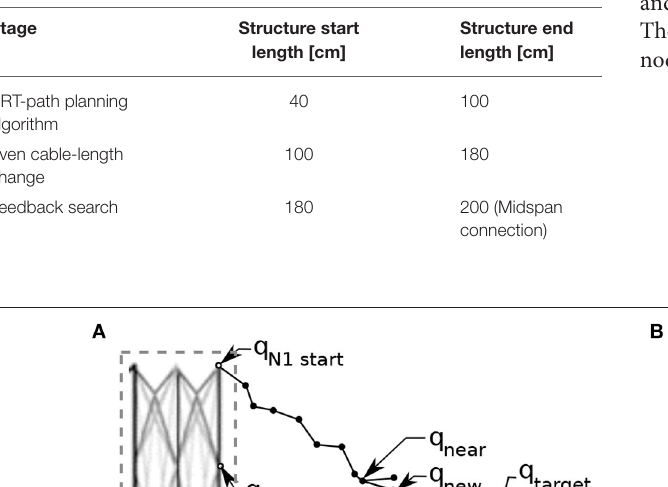
Frontiers in Built Environment |